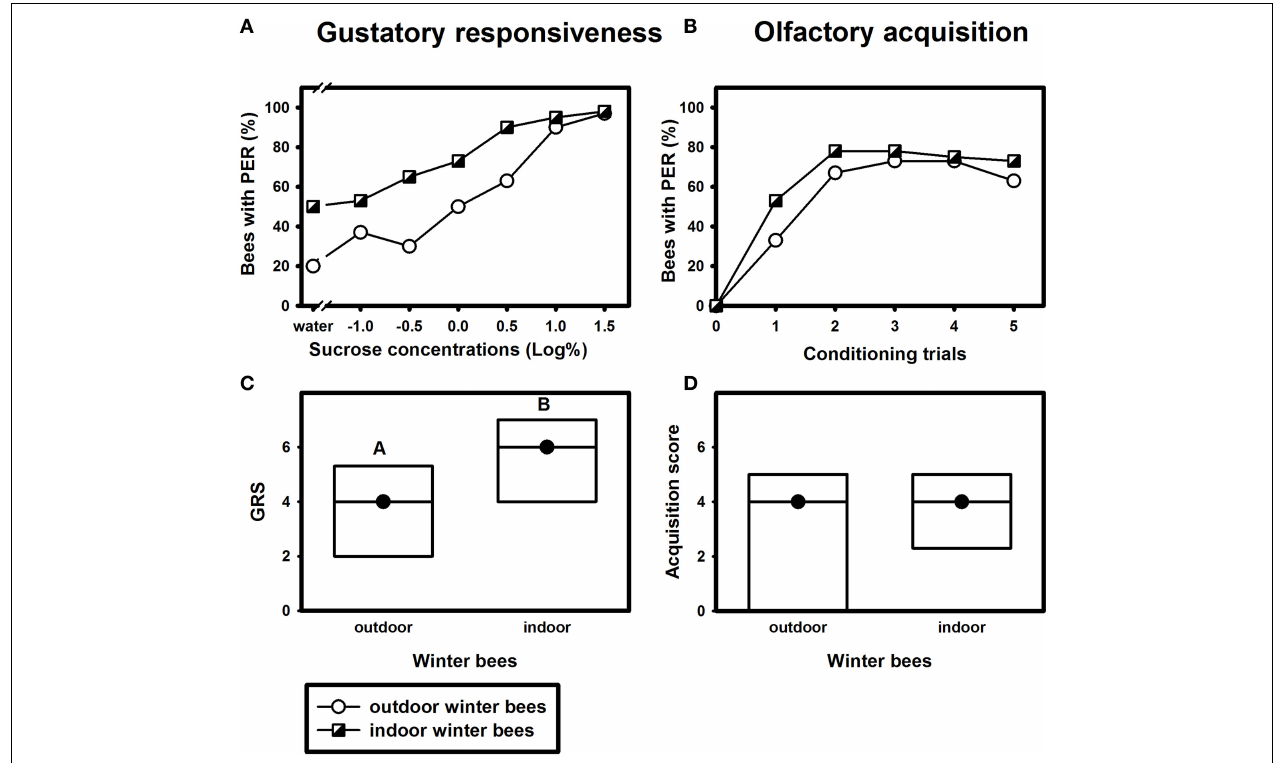
FIGURE 5 | Gustatory responsiveness and olfactory acquisition of outdoor winter bees and indoor winter bees. (A) Sucrose-concentration response curves of outdoor winter bees and indoor winter bees. The x -axis displays the sucrose concentration offered to the antennae of each bee. The y -axis shows the percentage of bees showing the proboscis extension response (PER). (B) Olfactory acquisition curves of outdoor winter bees and indoor winter bees. The x -axis displays the conditioning trials. The y -axis shows the percentage of bees showing conditioned PER. (C) Gustatory response